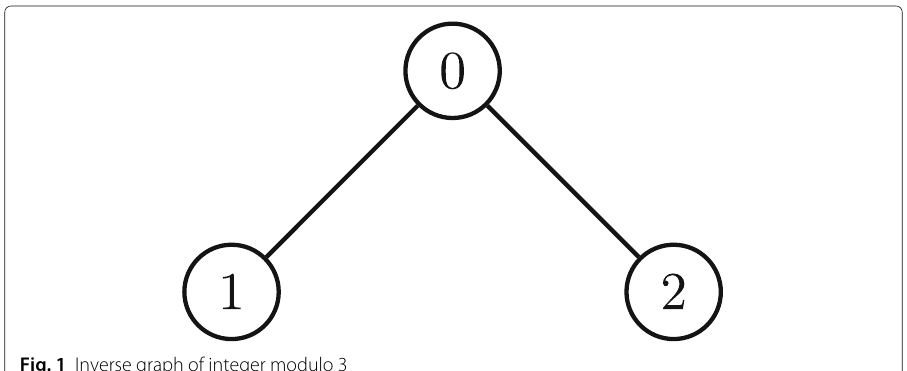
Fig. 1 Inverse graph of integer modulo 3